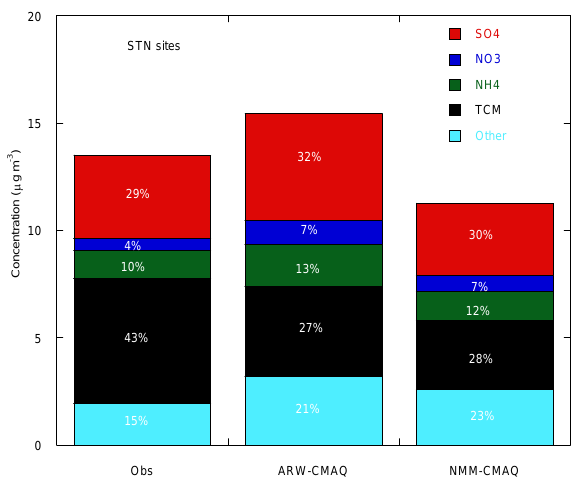
Fig. 4. Comparison of stacked bar-plots for observed and modeled Figure 4. Comparison of stacked bar-plots for observed and modeled (ARW-CMAQ, NMM- (ARW-CMAQ, NMM-CMAQ) PM 2 . 5 chemical composition at the CMAQ) PM 2.5 chemical composition at the STN sites during the 2006 STN sites during the 2006 TexAQS/GoMACCS period. The per- TexAQS/GoMACCS period. The percentages represent the fractions of each composition for PM 2.5 . “OTHER” species refers to unspecified anthropogenic mass centages represent the fractions of each composition for PM 2 . 5 . which comes from the emission inventory of PM 2.5 . “OTHER” species refers to unspecified anthropogenic mass which comes from the emission inventory of PM 2 . 5